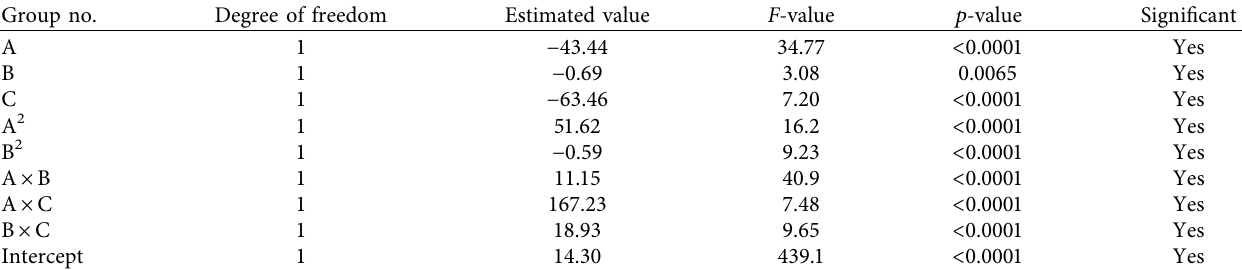
Table 5: Fitted quadratic equations of weight loss after 120 salt freeze-thaw cycles at air content of (2.5 ± 0.5)%. Group no.